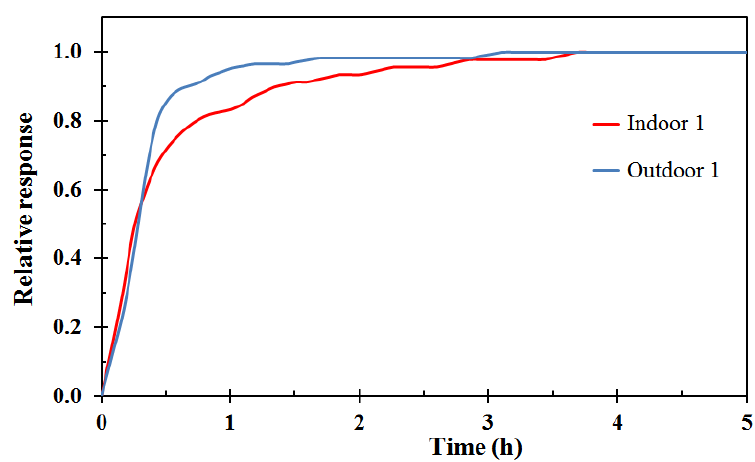
Figure 3. Weather station number 1 indoor (red) and outdoor (blue) sensors relative response to a near step change in relative humidity from 75% RH to 11% RH.